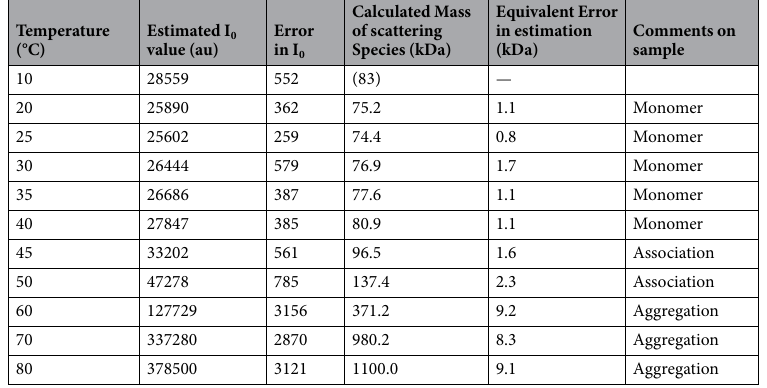
Table 1. Estimated molecular mass values of the scattering species in solution of gelsolin at different temperatures are tabulated below. The I 0 values have been estimated from Guinier analysis of the SAXS datasets (Mass of full-length gelsolin is 83 kDa). Calculated Mass at temperature X = 83 * [I 0 value at X]/[I 0 value at 10